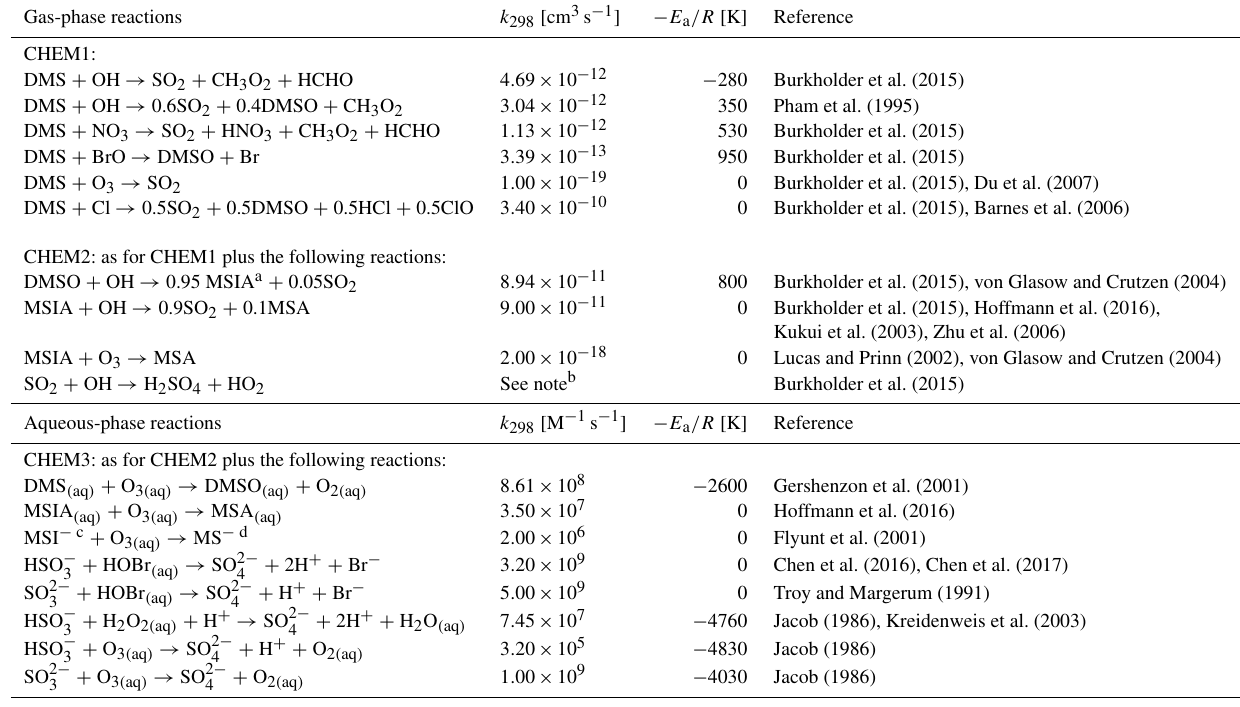
Table 3. Reaction schemes tested with the CHEM1, CHEM2 and CHEM3 sensitivity simulations. Gas-phase